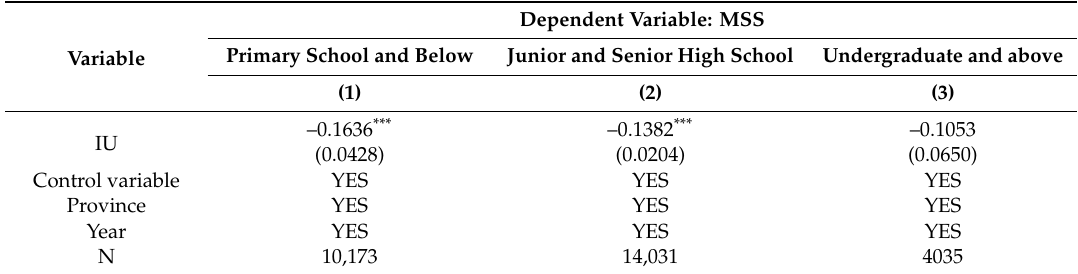
Table 7. Internet use and medical service satisfaction: Subdivided sample analysis (by education).